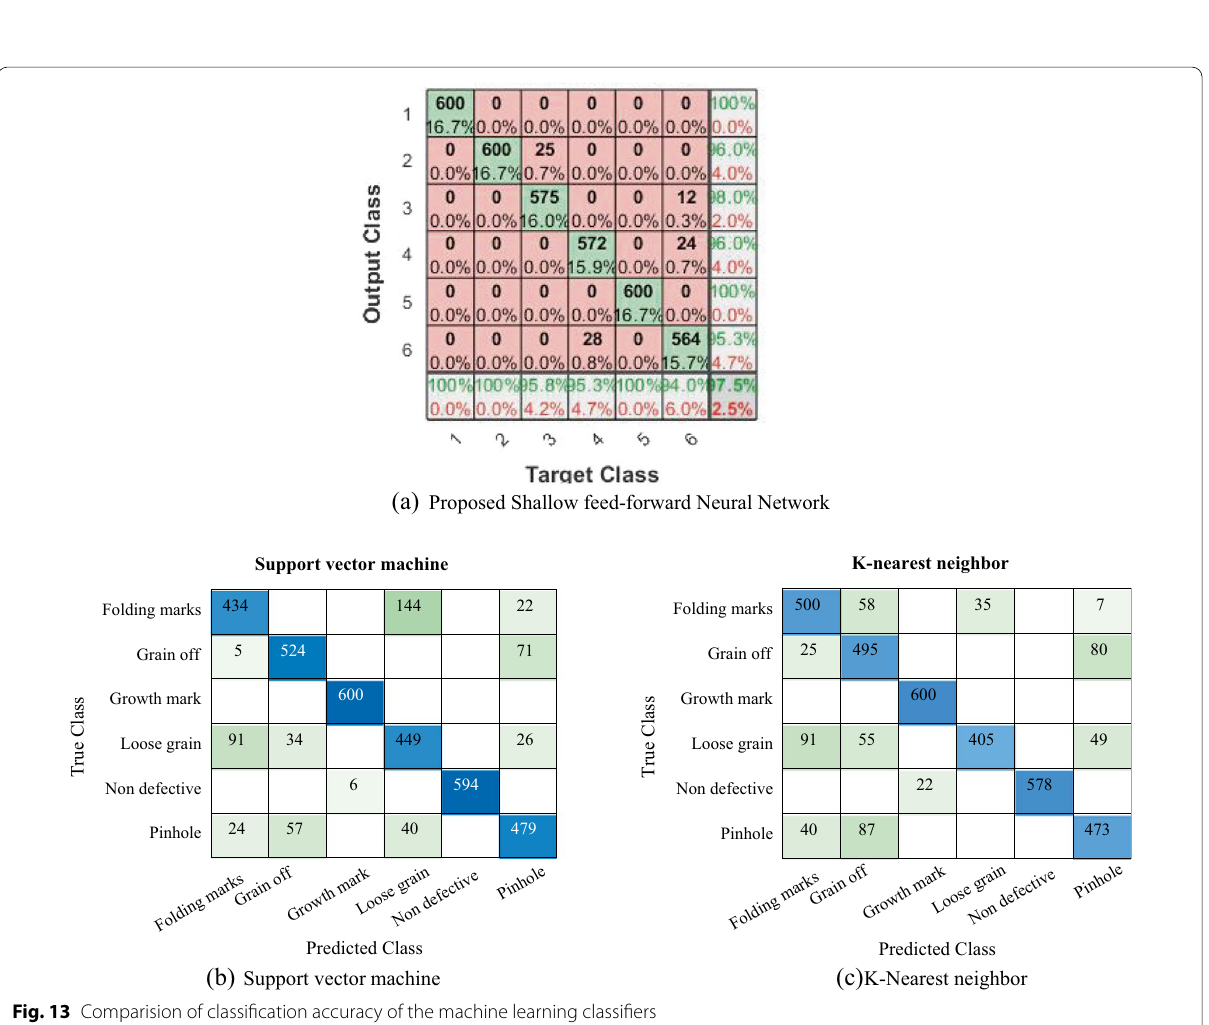
each class of leather. Further, the bottom row of the con- fusion matrix shows the sensitivity and false-positive rate. Due to the superior feature extraction capability with the kernel structure, Alexnet performed better with